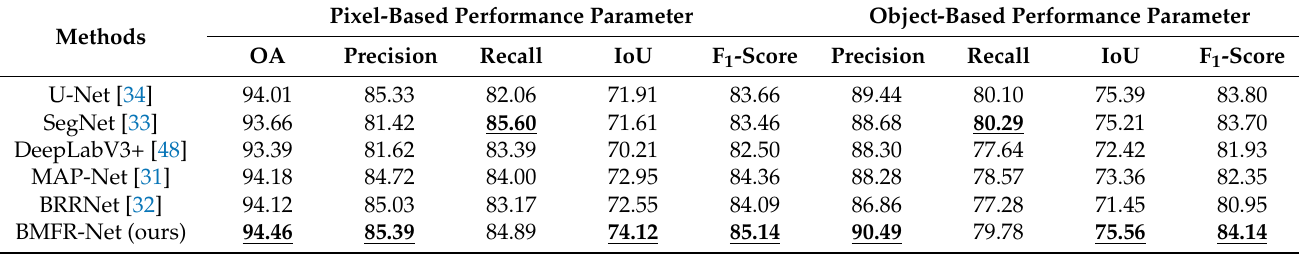
Table 3. Quantitative evaluation (%) of several SOTA methods on the Massachusetts Building Dataset. The best metric value is highlighted in bold and underline.